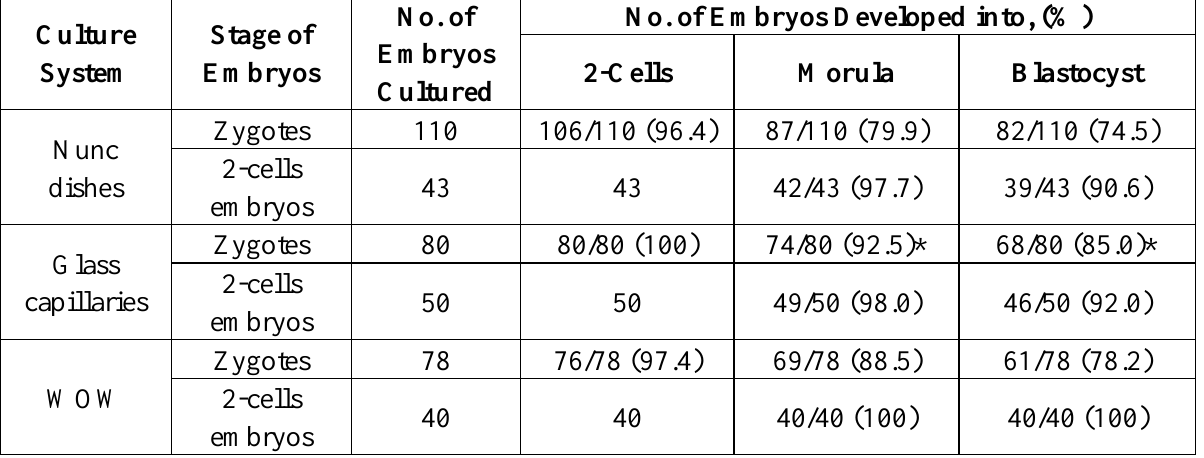
Table 5 . In vitro development of mouse embryos using various culture